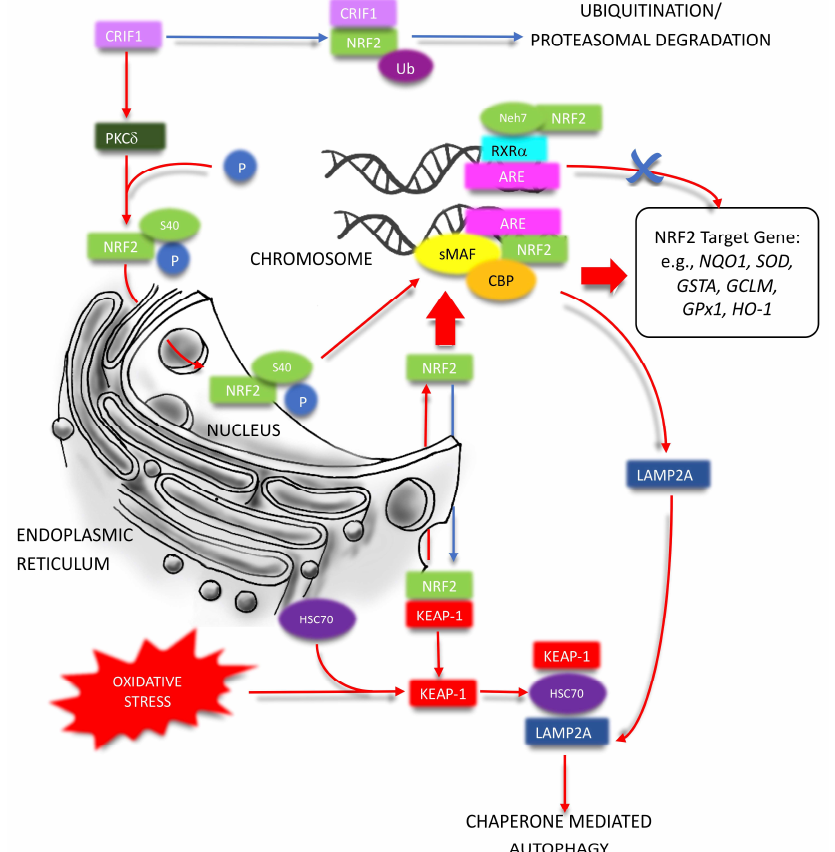
Figure 2. Diverse positive and negative regulation of NRF2 expression (2). Red lines denote positive and blue ones represent negative. ARE—antioxidant response element; CBP—CREBP/cyclic adenosine monophosphate response element binding protein; CRIF1—CR6-interacting Factor 1; CUL—cullin; GSTA —glutathione S-transferase A; GCLM —glutamate-cysteine ligase modifier subunit; GPx1 —glutathione peroxidase 1; HO-1 —heme oxygenase-1; HRD1 —SYVN1/synoviolin E3 ubiquitin ligase; HSC70—Heat shock cognate 71 kDa protein/HSPA8; KEAP1—Kelch-like ECH-as-